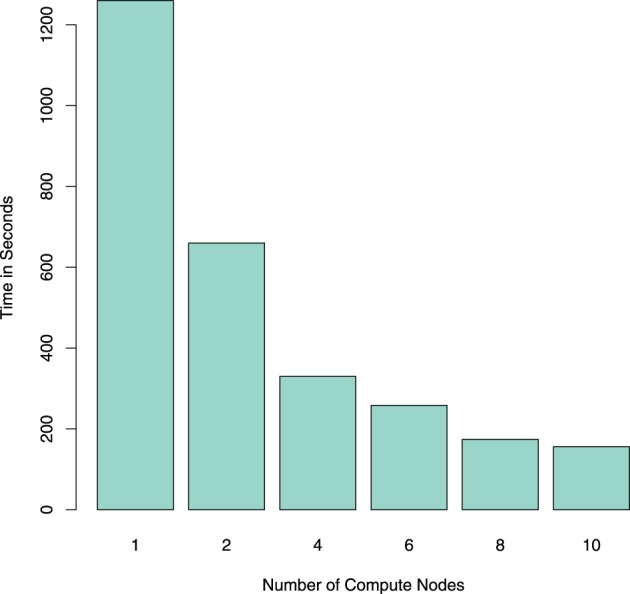
Comparing the runtime (in seconds) for reading one resting-state fMRI dataset using NiftiImageReadMasked on an Apache Spark cluster with different numbers of compute nodes. Note that the reduction in computation time scales almost with 1/n, n being the number of nodes in the cluster.